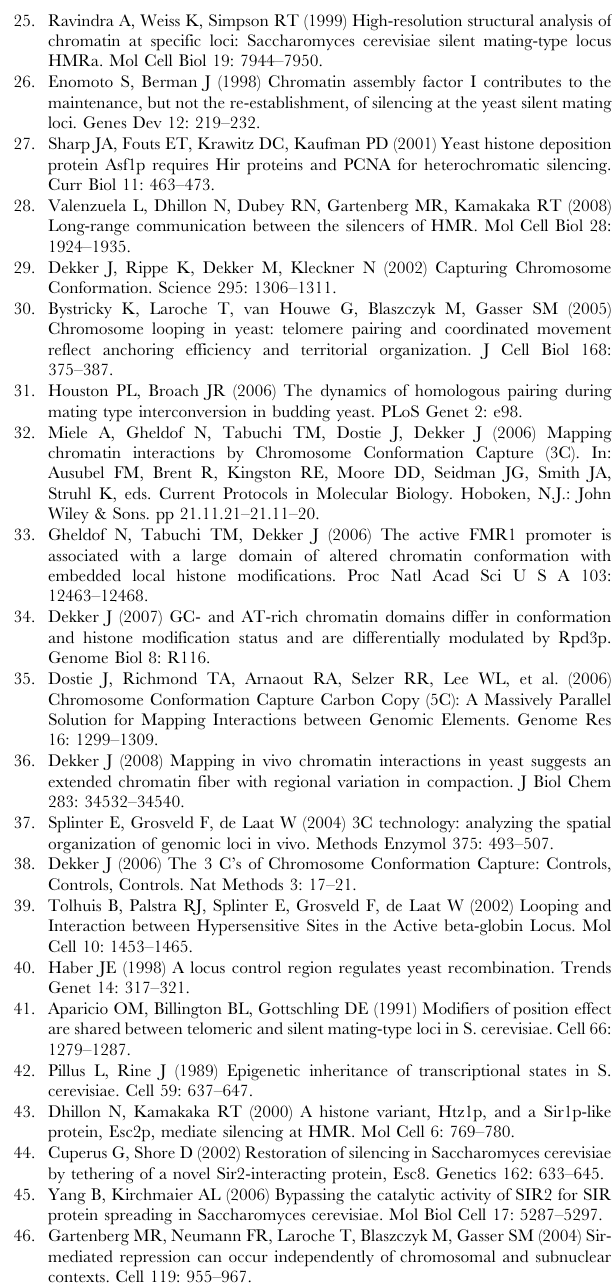
Table S2 Yeast strains used in this study. Strains marked with an asterisk have been previously described in Bystricky et al. (2005; 2009) [30,47]. Table S3 Values for 3C signal strength, control PCR signal strength, crosslinking frequencies, averaged crosslinking frequen- cies, standard error of the mean, normalized average crosslinking frequency, and normalized standard error of the mean are listed for MAT a cells. Values for normalized average crosslinking frequency and normalized standard error of the mean are listed for MAT a cells and all mutants